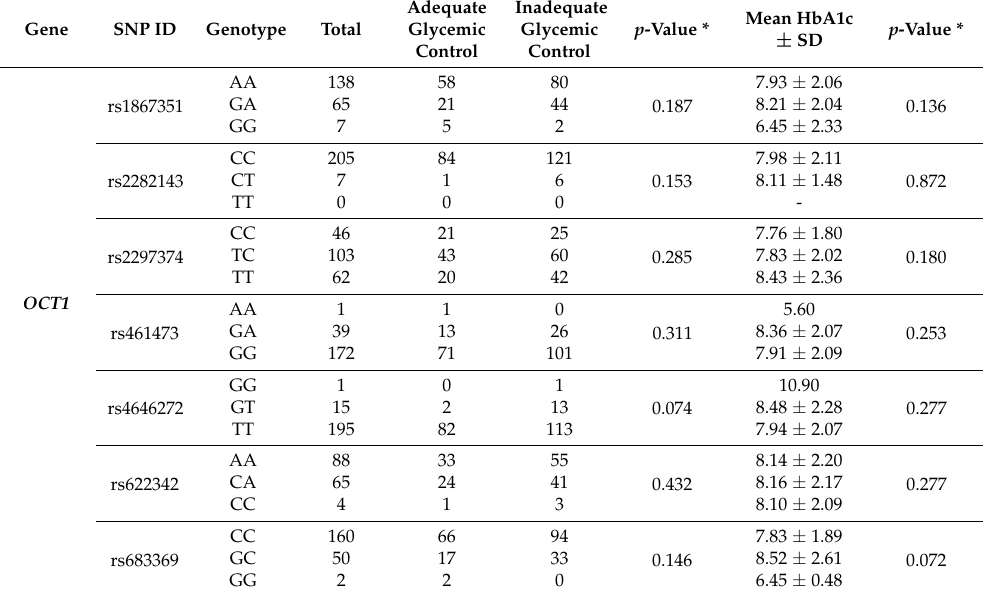
Table 4. Effect of genotype distribution of studied SNPs for OCT1 gene on glycemic control and on HbA1c level in Jordanian T2DM patients receiving metformin.